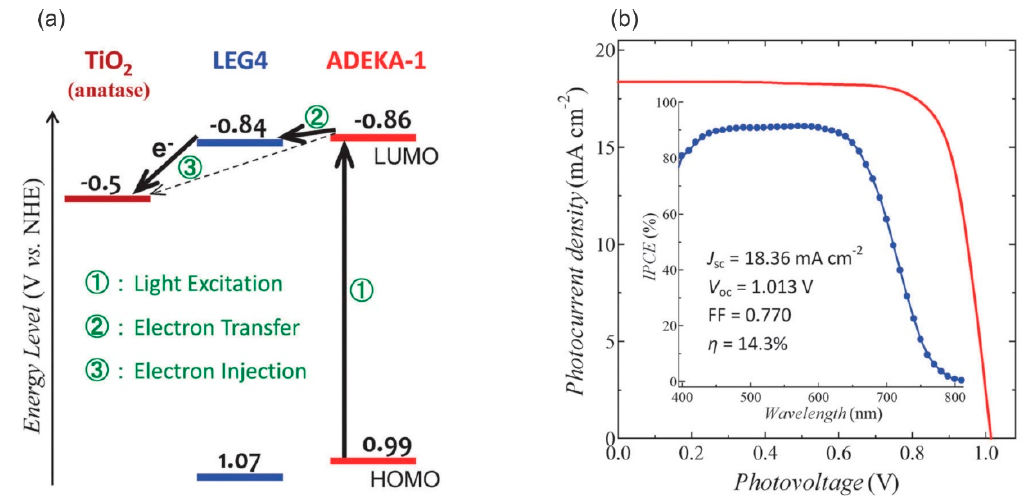
Figure 8. ( a ) Energy level diagram for the LEG4 and ADEKA-1 dyes and ( b ) IV curve of the